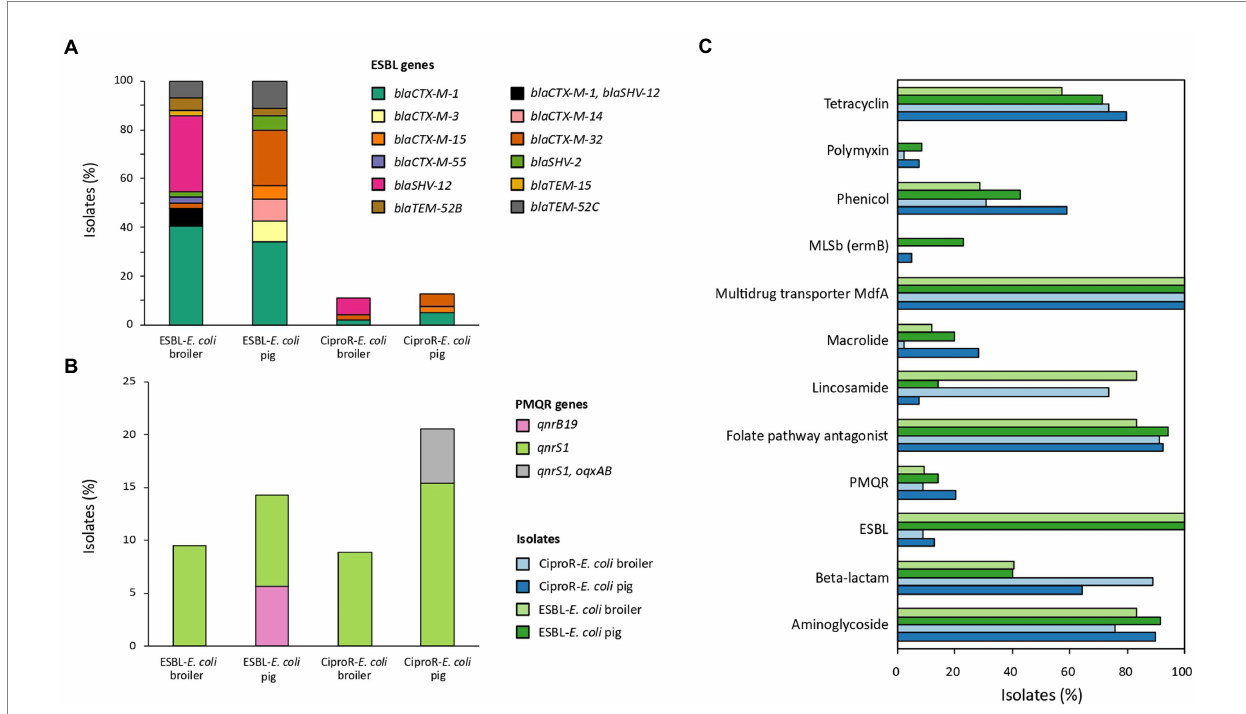
FIGURE 1 The percentage of isolates carrying ESBL genes (A) , plasmid-mediated quinolone resistance (PMQR) genes (B) and genes conferring resistance to other antibiotic classes (C)